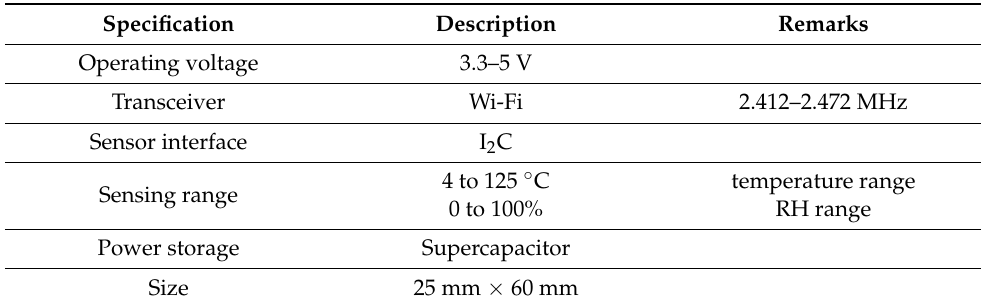
Table 4. Sensor node specification.